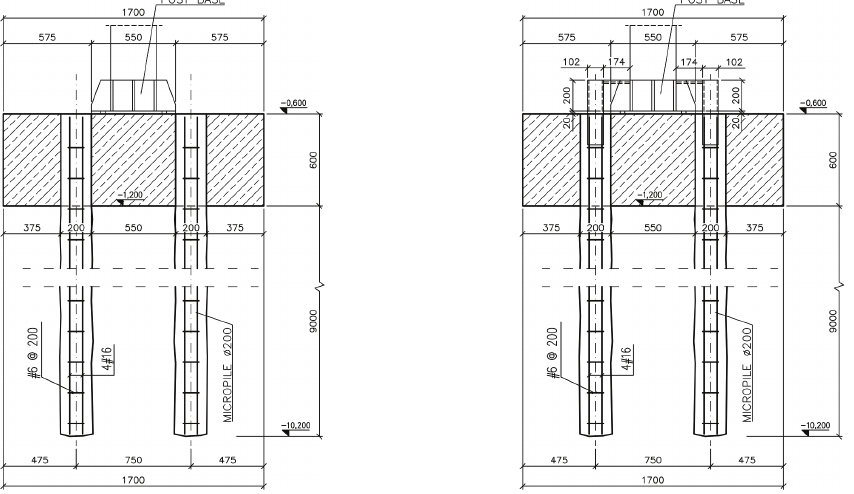
Fig. 3a. Alternative pile anchorage in foundation Fig. 3b. Pile anchorage in post through steel construction